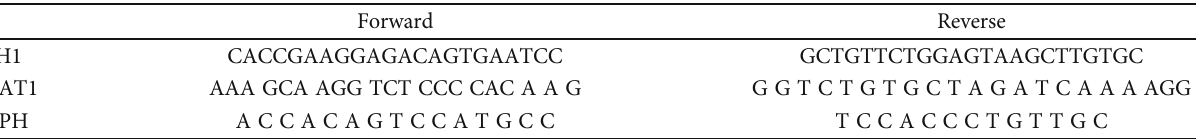
Figure 1: Surgical procedure: (a – d) modi fi ed round block technique; (e – g) modi fi ed radical Table 1: The studied gene primer sequence.